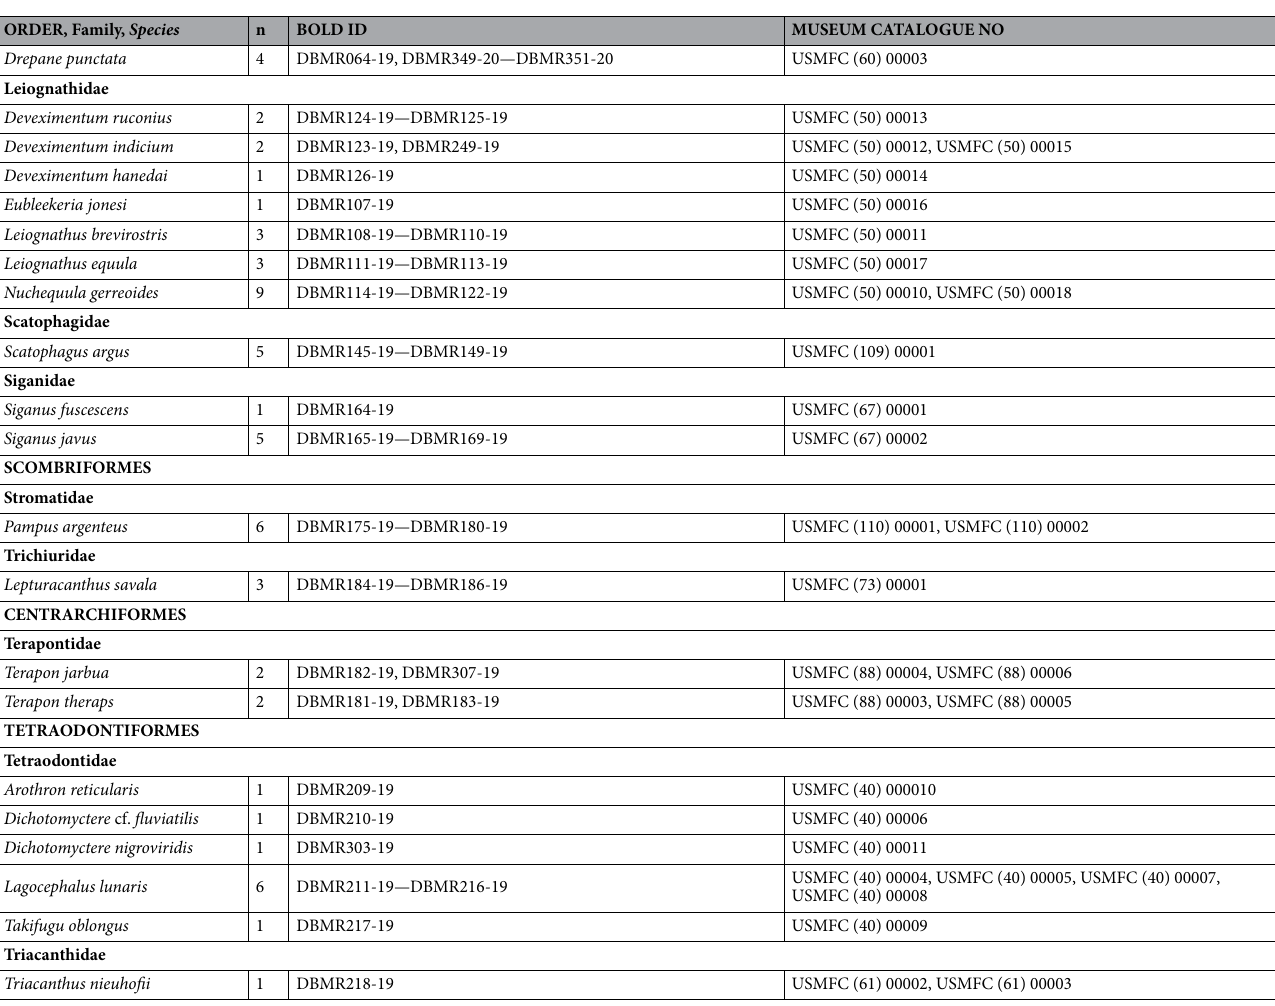
Table 1. List of morphology-based species from Merbok Estuary region studied through DNA barcoding with the number of specimens examined (n), the BOLD IDs of their respective COI sequences, and the museum catalogue numbers of each